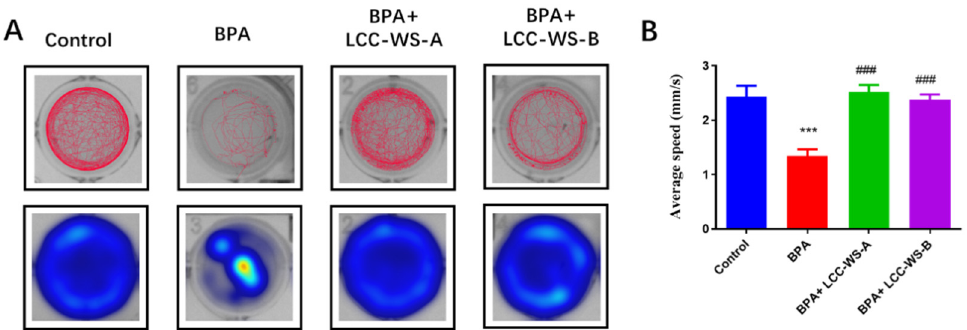
Figure 3. Effects of different treatments on the locomotor behavior of 6 dpf zebrafish larvae. Representative movement tracks and heat maps ( A ). Average speed ( B ). *** p < 0.001, compared with the control group. ### p < 0.001, compared with the BPA-treated group.